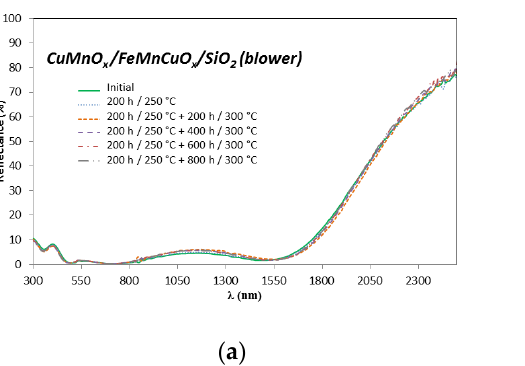
Figure 7. Photographs of the Al/CuMnO x /CuFeMnO x /SiO 2 (blower) selective absorber before ( a ) and after ( b ) the thermal stability test.